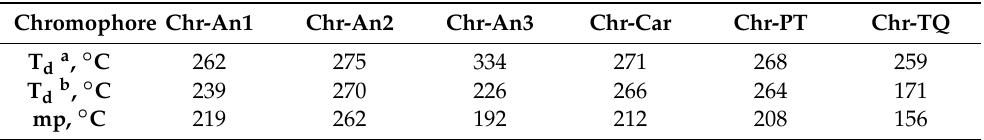
Figure 4. DSC curves of Chr-An1 ( a ), Chr-An2 ( b ), Chr-An3 ( c ), Chr-Car ( d ), Chr-PT ( e ) and Chr- TQ ( f ). Previously [29], we found that thermal stability for quinoxaline-based chromophores estimated using TGA is somewhat overestimated due to the occurrence of decomposition without weight loss; thus, DSC seems to provide more reliable determination of thermal stability for this class of compounds. For Chr-An3 with a TBDMSO group and the hexylene spacer, TGA and DSC techniques provide notably different estimations of ther- mal stability, similar to the case of earlier-studied quinoxaline-based chromophores with dibutylaniline donors, while for Chr-An1 and Chr-An2 with the substituent containing the ethyl spacer, the difference in the obtained values of thermal stability estimated by the two methods is much smaller (Figure 4). Changing the aniline donor for a heterocyclic donor (chromophores Chr-Car and Chr-PT ), on the other hand, results in close values of thermal stability obtained using TGA and DSC. T d , obtained using DSC, is higher for these ( a )